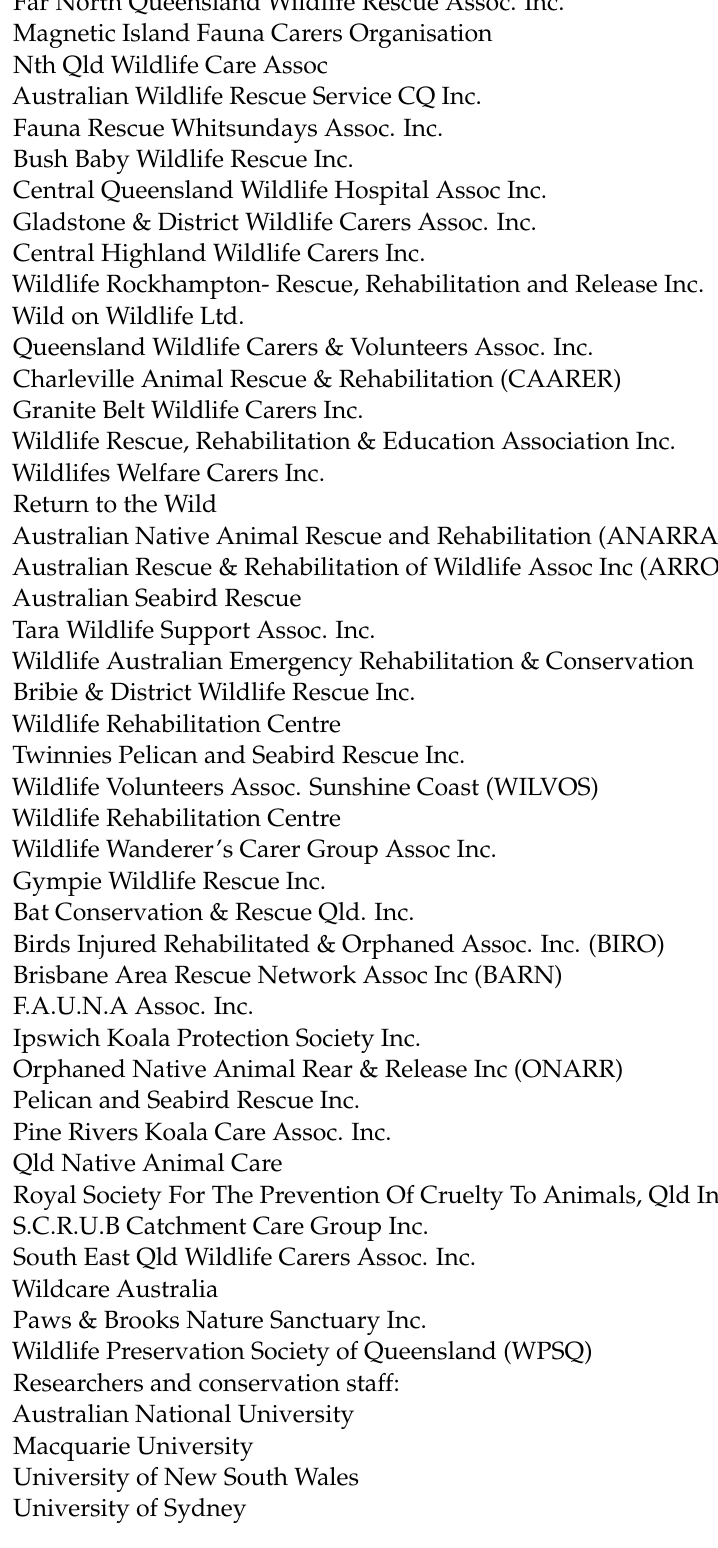
Tableland Wildlife